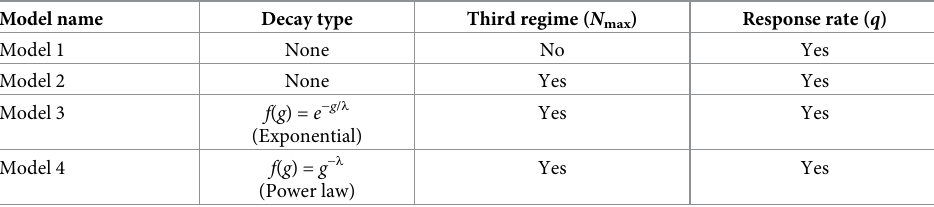
Table 1. Discussion trees model